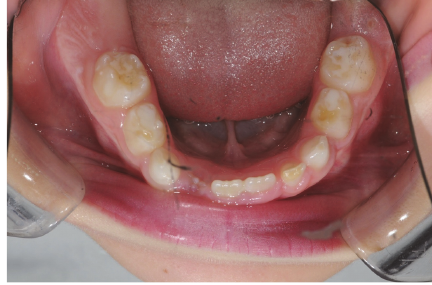
Figure 6: Lower arch,